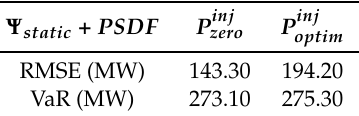
Figure 3. Error distribution for the PST optimized PTDF matrix representation when applying the P inj zero and P inj datasets. optim Table 8. Performance indexes for the reduced model, with an explicit PST